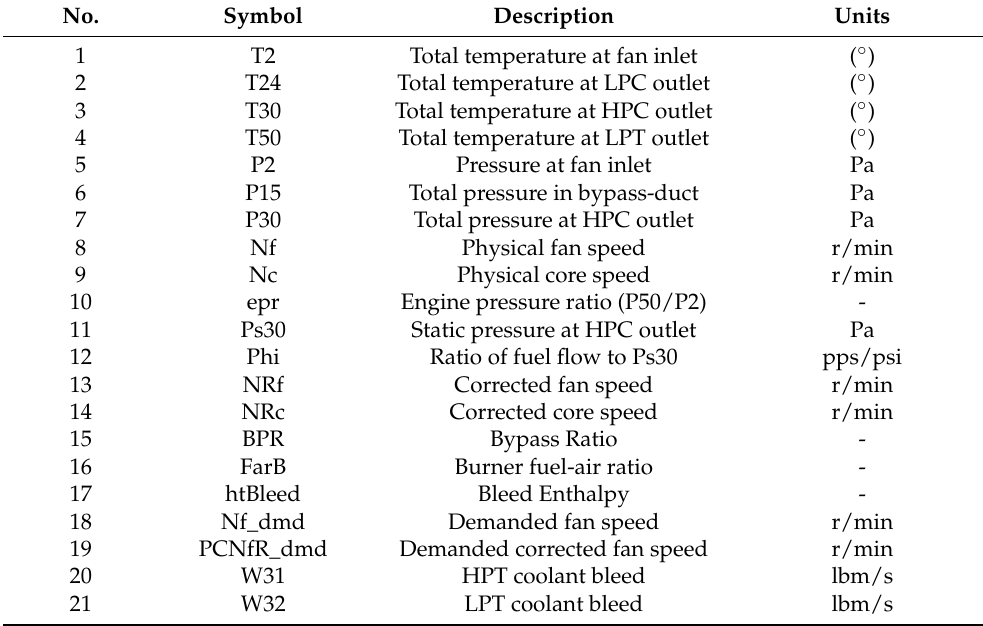
Table 2. C-MAPSS outputs to measure system